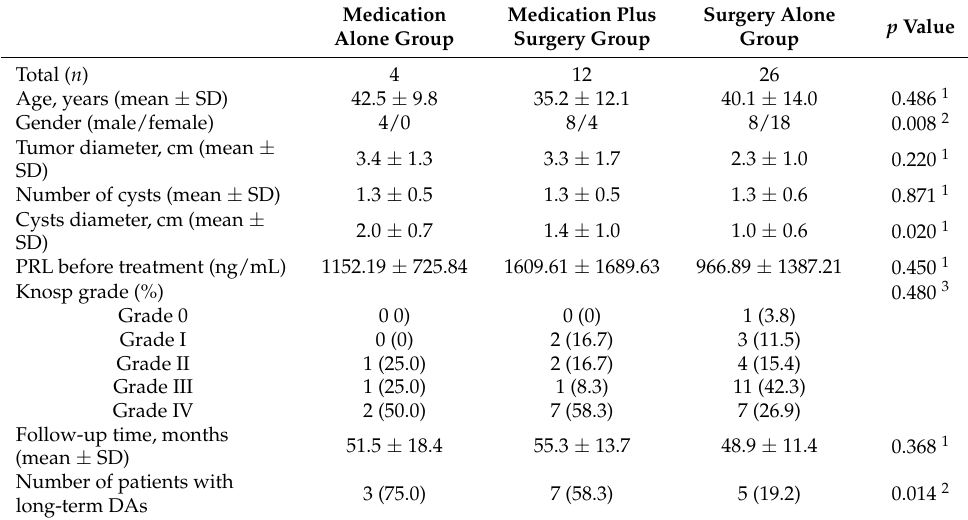
Table 2. Clinical characteristics of 42 patients of cystic pituitary prolactin-secreting macroadenomas with different treatment methods.